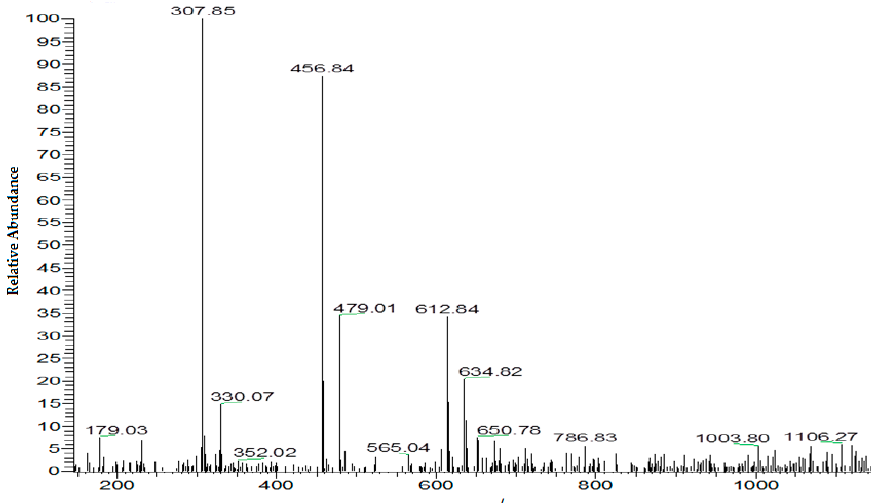
Figure 13. Microfluidic device coupled offline to mass spectrometry (MS).